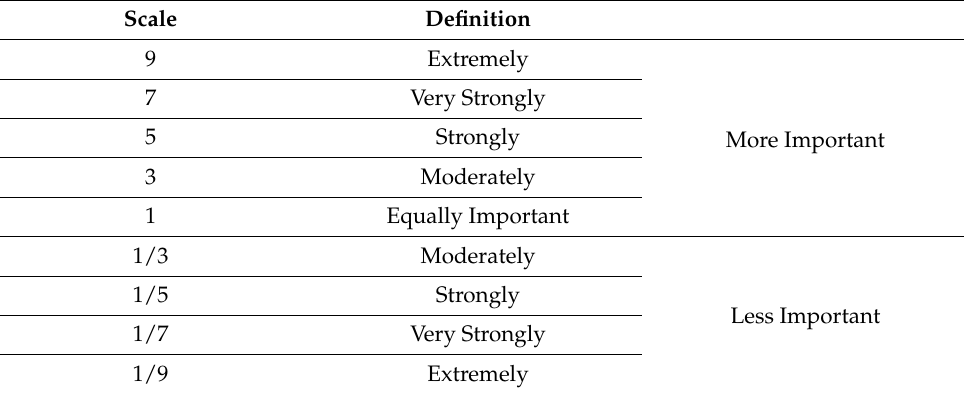
Figure 2. A schematic of WLC, AHP, and ensembled model for watershed erosion-potential mapping. Table 1. Scale for AHP Comparisons.